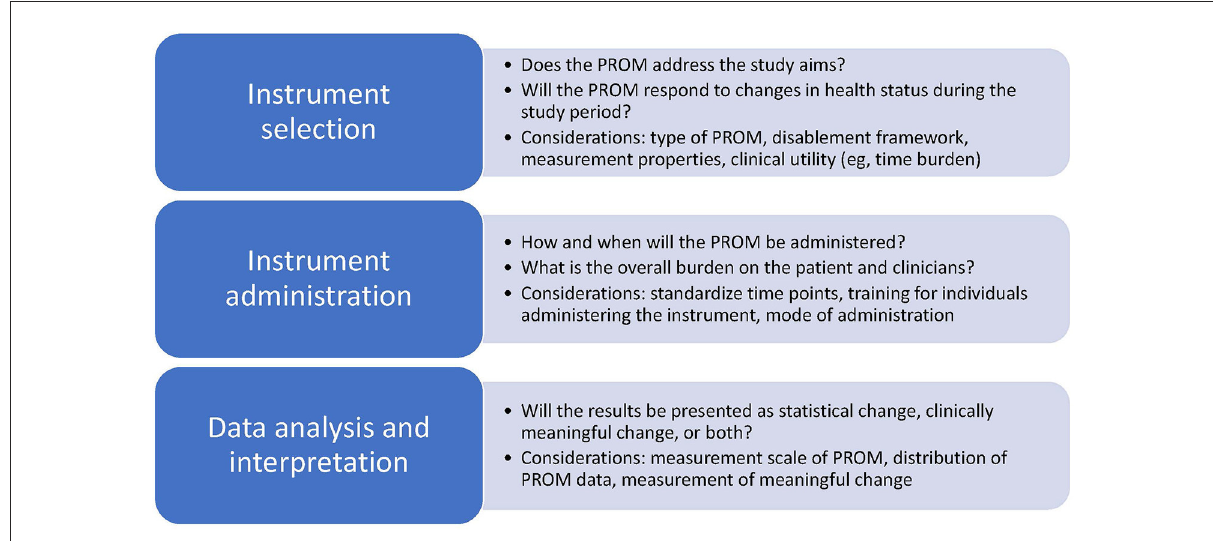
FIGURE1 Considerations for instrument selection, administration, and analysis and interpretation for research using patient-reported outcome